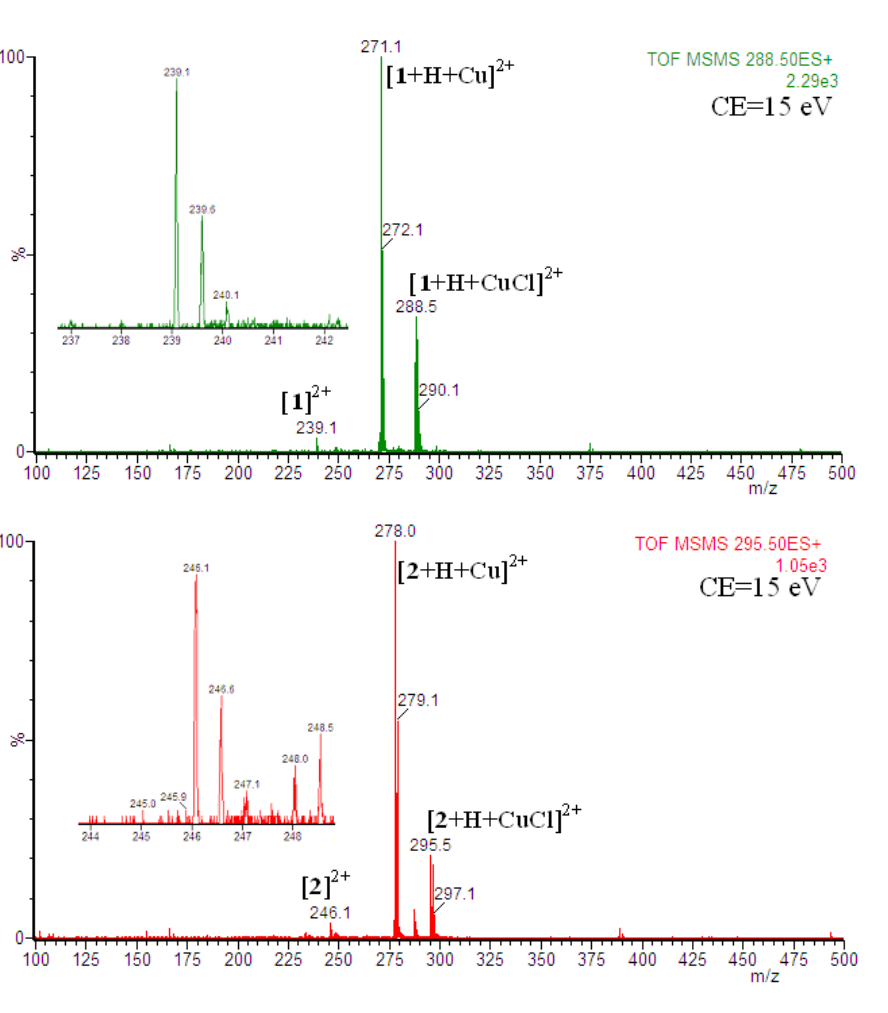
Table 1: Adiabatic and vertical ionization potentials (IP, eV) of 1 , 2 and 3 .